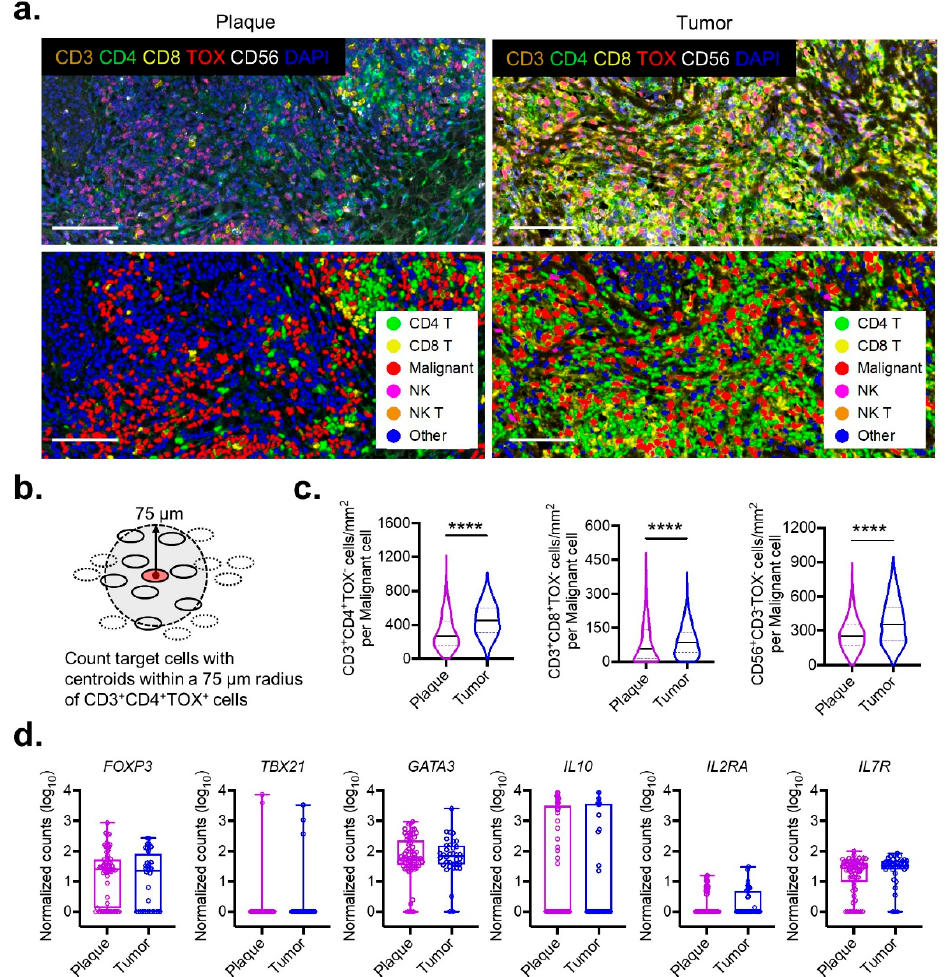
Figure 2. Microarchitecture progression from plaque to tumor stage in MF. ( a ) Representative multispectral images (top) and cell segmentation with phenotype map (bottom) from plaque and tumor stage MF stained with the indicated biomarkers (scale bar 100 µ m). ( b ) Schematic diagram for enumerating all cells of a specific phenotype within a 75 μ m vicinity of malignant CD3 + CD4 + TOX + cells. ( c ) Violin plots of composite data enumerating density of CD3 + CD4 + TOX − , CD3 + CD8 + TOX − , and CD56 + CD3 − TOX − cells within the vicinity of malignant cells as described in panel ( b ) for pooled plaque ( n = 5) or tumor ( n = 2) MF samples. At least five regions of interest were quantified for the analysis. ****, p < 0.0001 by unpaired t -test with Welch’s correction. ( d ) Normalized tissue RNA expression for the indicated genes between plaque- ( n = 63) and tumor- ( n = 36) stage MF samples. Bar plots represent mean ± SEM. Violin plots represent the median with 25th and 75th percentiles.